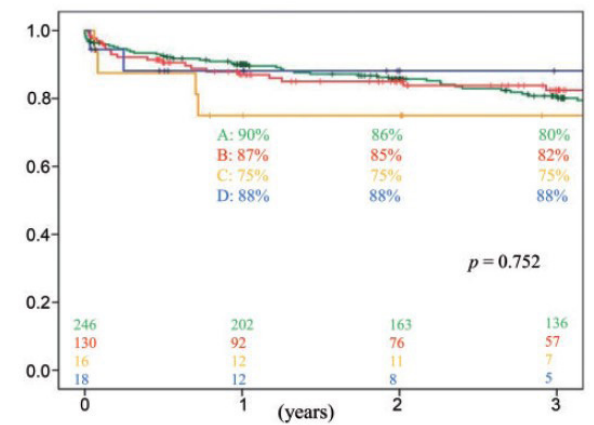
Fig. 6 - Overall survival rates after OHT in each group. Group A, heart transplantation without mechanical circulatory support (green); Group B, long-standing MCAD bridge (red); Group C, bridge with short-term MCAD (yellow); and Group D, bridge with short- and long-term devices (blue). Yoshioka D, Li B, Takayama H, Garan RA, Topkara VK, Han J et al. Outcome of heart transplantation after bridge-to-transplant strategy using various mechanical circulatory support devices. Interact CardioVasc Thorac Surg.